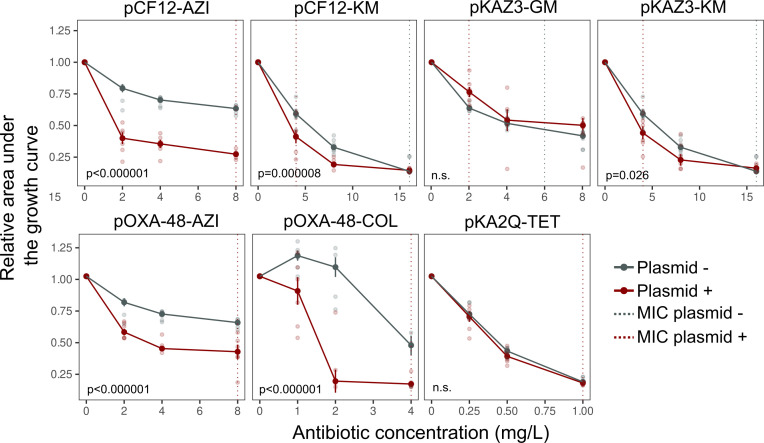
Analysis of bacterial growth curves.Comparison of the relative area under the growth curve of MG1655 (gray lines) and its plasmid-carrying derivatives (red) under different antibiotic concentrations. Each data point corresponds to the mean of 6–12 biological replicates and error bars correspond to the standard error of the mean. Individual data points are also represented. Vertical lines indicate MIC values for plasmid-bearers (red dashed line) and plasmid-free strains (gray dashed line). MIC values that would lie outside plot ranges are omitted. p-Values are provided for the significantly different comparisons (ANOVA effect of ‘plasmid x antibiotic concentration’ interaction; ANOVA results are shown in Supplementary file 1B). AZI: azithromycin, COL: colistin, GM: gentamycin, KM: kanamycin, TET: tetracycline. Files accompanying this manuscript.
Figure 1—figure supplement 2—source data 1.Numerical data that are represented in Figure 1—figure supplement 2.